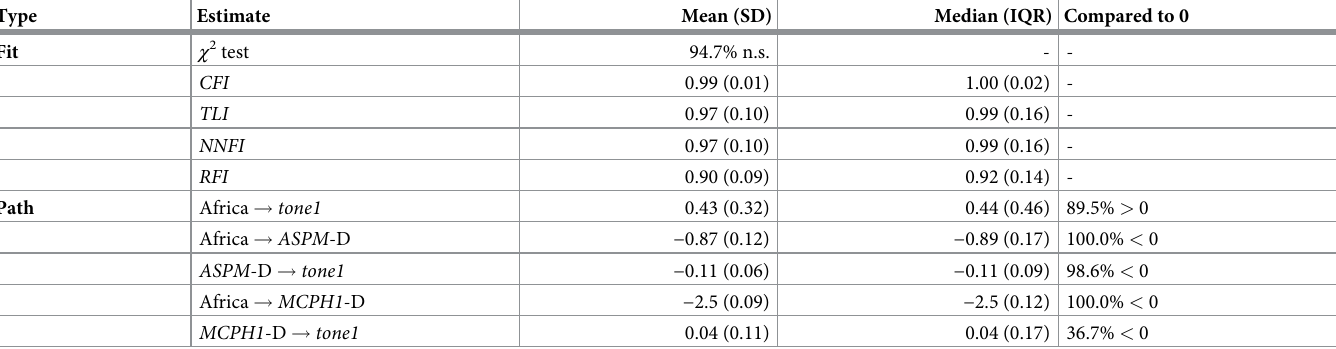
Table 10. Summaries of the path analysis for 1,000 restricted samples for tone1 . Similar conventions as for Table 9.